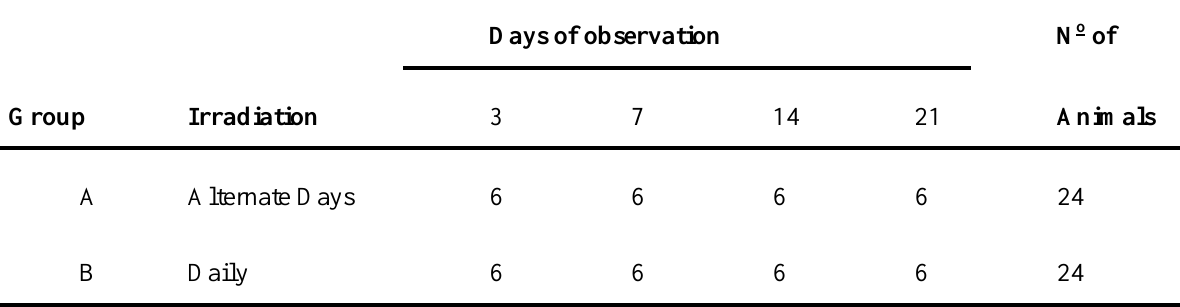
TABLE 1 – Distribution of the animals into groups based on the frequency of irradiation and time of